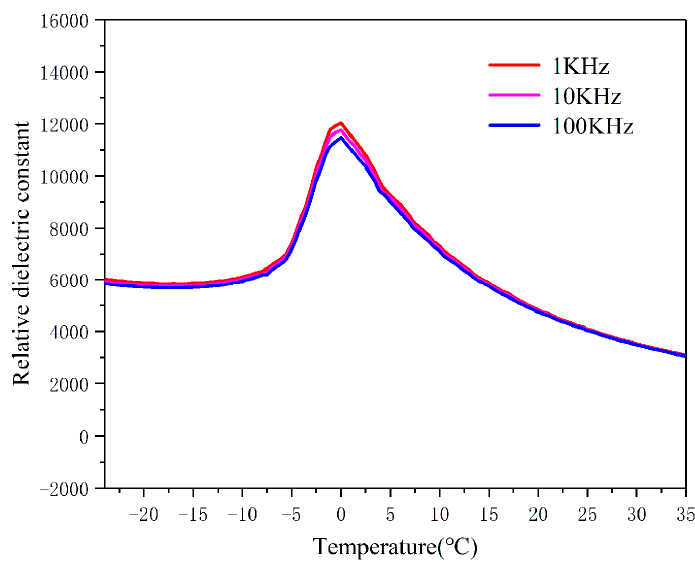
Figure 3. Relative permittivity.